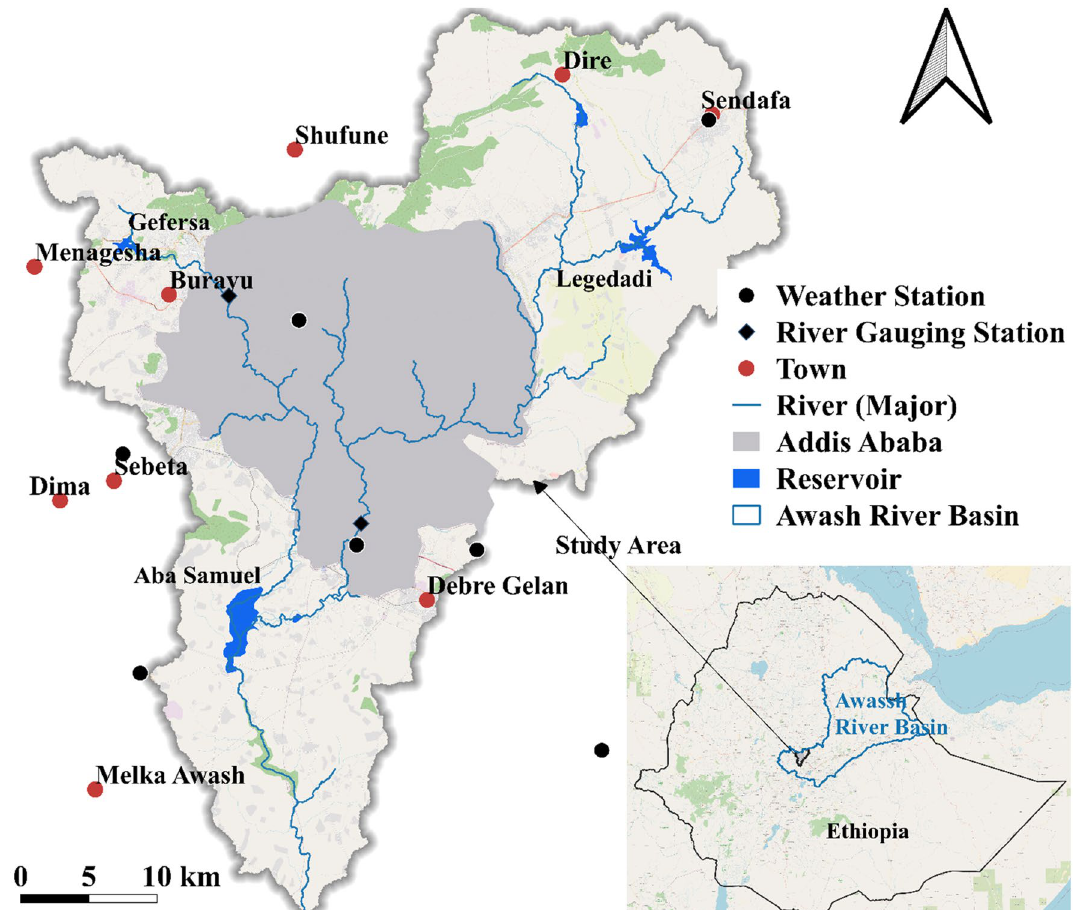
Figure 1. Description of the study area, including Major River networks, gauging stations, and reservoirs processed using QGIS3.10.4 (https:// www. qgis. org/ en/